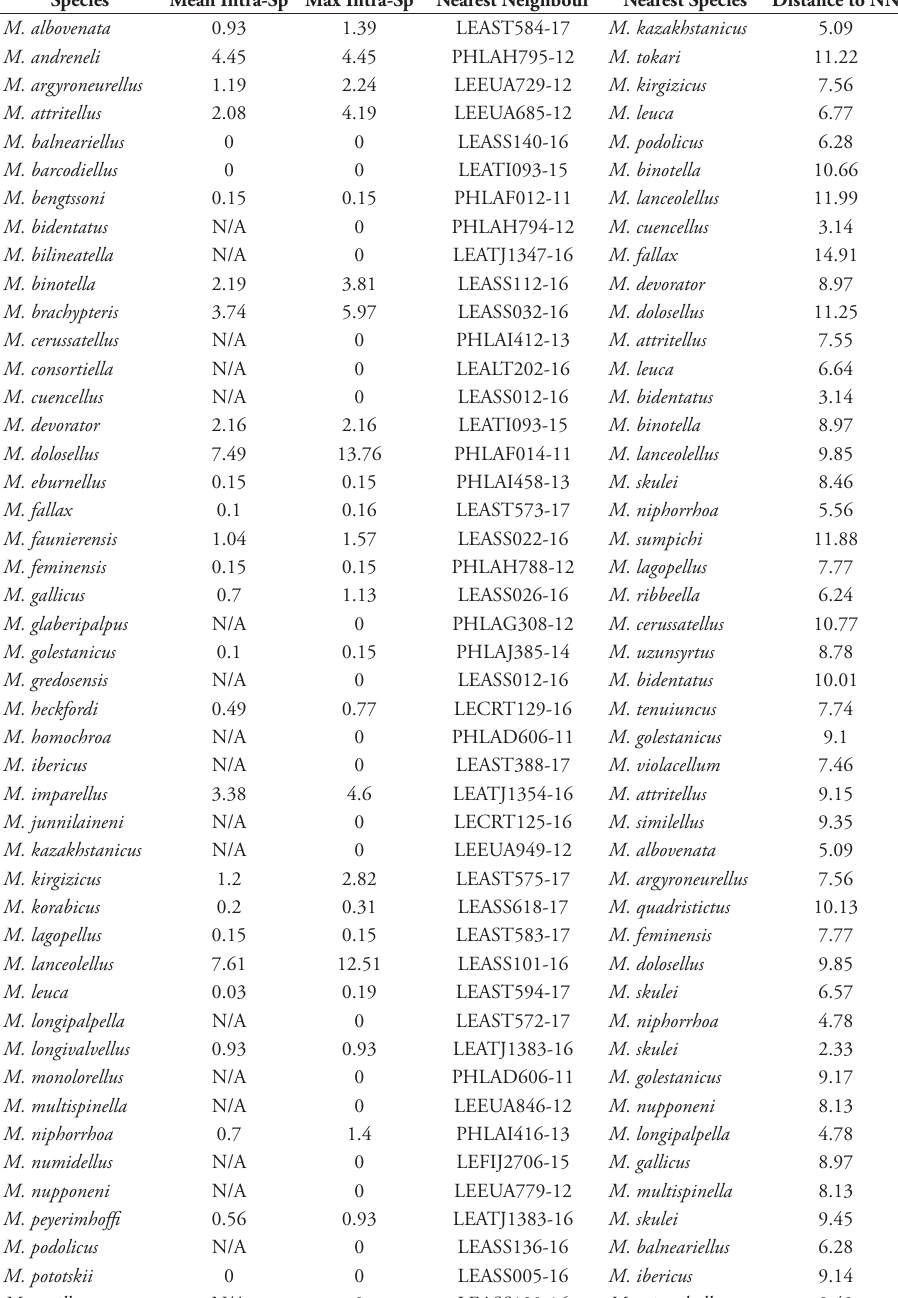
Table 1. COI sequences in Megacraspedus . Intraspecific mean K2P (Kimura 2 parameter) divergences, maximum pairwise distances, and distance to the nearest neighbour in